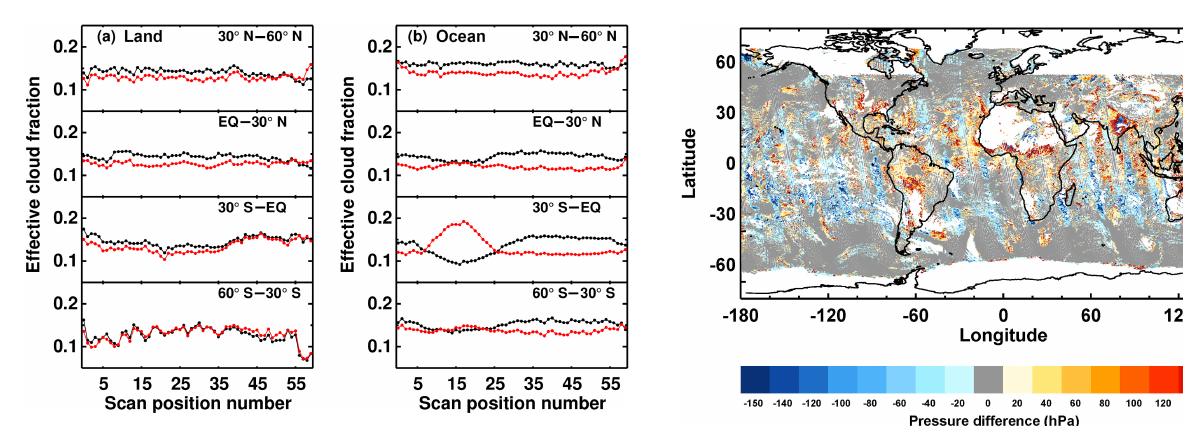
Figure 14. Differences between OCPs retrieved with GLER and climatological LER for 13 November 2006. Data are shown for ECF > 0 . 05 only.